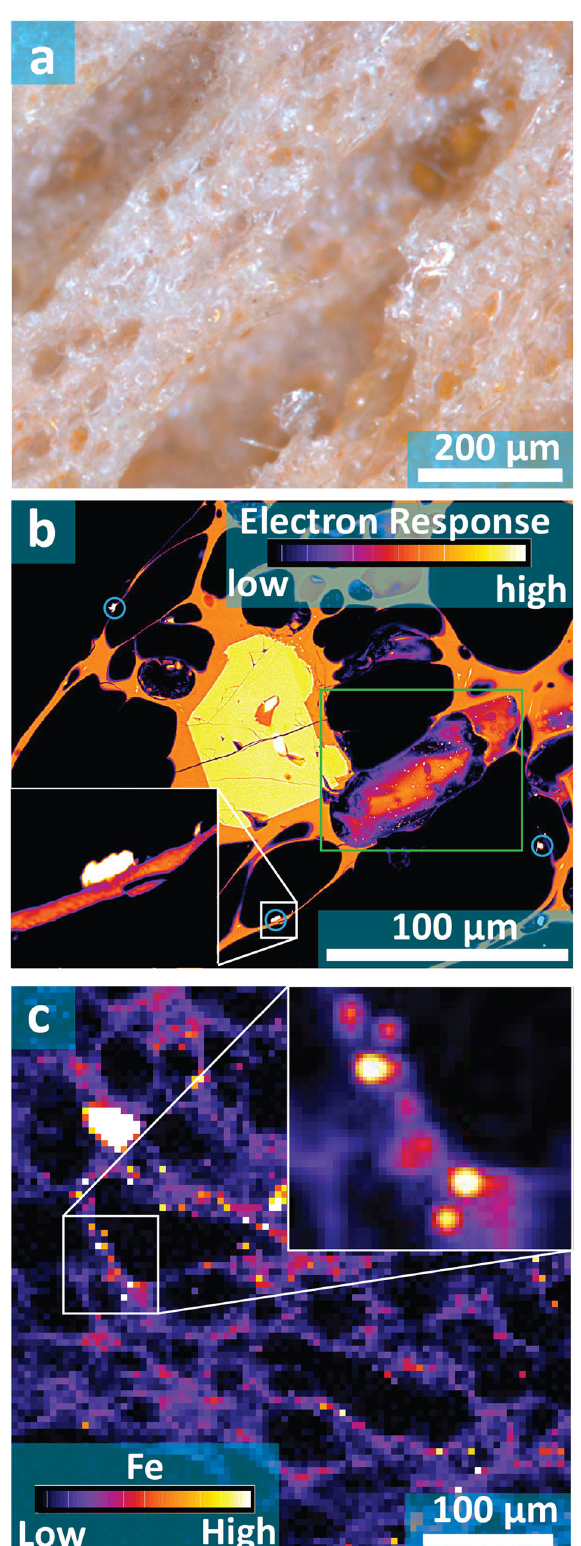
Fig. 2 Microlites and nanolites on vesicle walls in natural pink pumice. a Optical stereoscope image of natural pink pumice showing vesicle rims and walls marked by an orange-red staining . b BSE image showing magnetite microlites/nanolites (white) within the pumice glass (orange-yellow), where black spaces correspond to vesicles or void spaces. Note the view of the preserved concave vesicle wall (outlined by green box) that contains abundant magnetite nanolites to microlites. Blue circles highlight magnetite microlites occurring along vesicle walls. The large yellow crystal in the centre of the image is an orthopyroxene microlite. c An enlarged area of the XFM Fe elemental map of the pink raft pumice (Fig. 1i) showing a vesicle lined with numerous pixels with high Fe concentrations (white) interpreted to be magnetite microlites/nanolites. XFM elemental maps resolution is limited to 5 µ